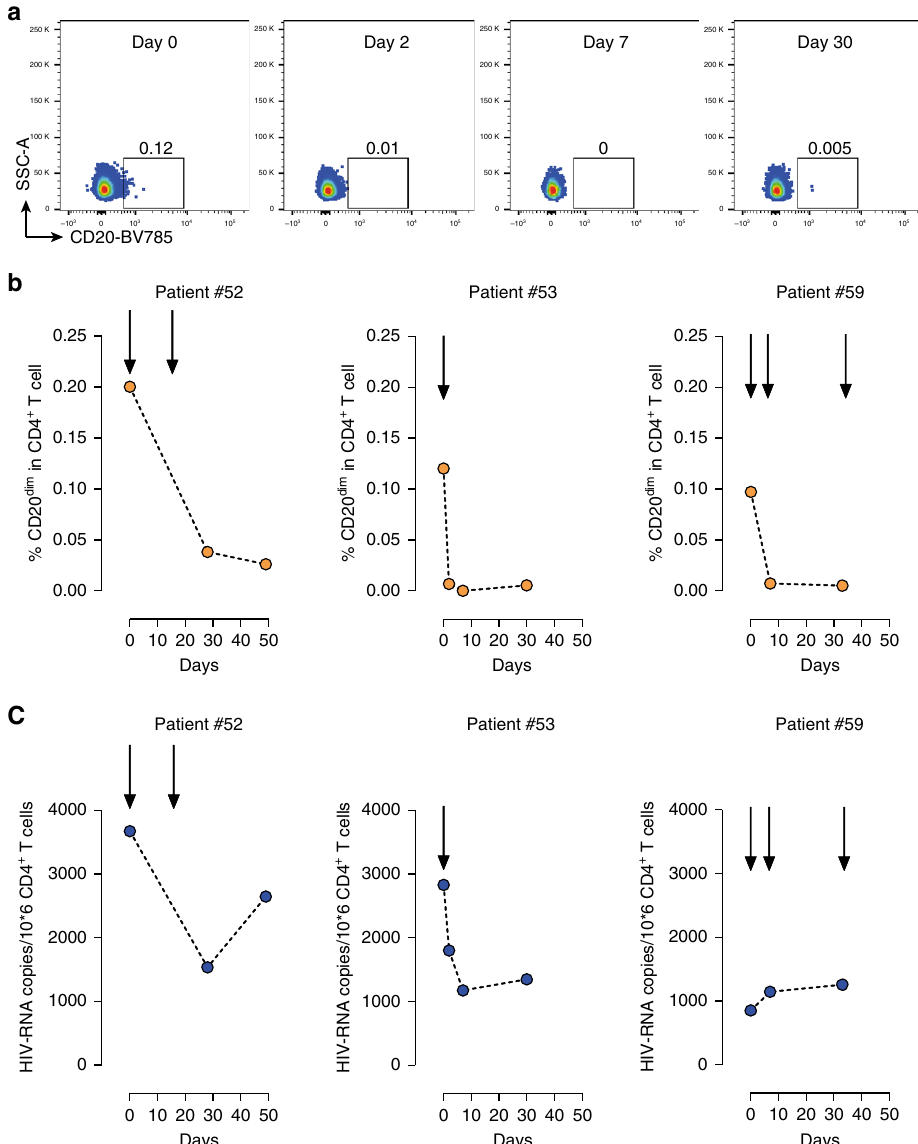
Fig. 7 Effects of Rituximab treatment in CD20 dim CD4 + T cells and intracellular HIV RNA. Three ART-suppressed patients were treated with Rituximab at indicated times (arrows) and blood samples were longitudinally collected. a Flow plots, following the same gating strategy as shown in Fig. 1a, of CD20 expression in CD4 + T cells in patient #53 are shown. b Frequencies of CD20 dim CD4 + T cells in longitudinal samples from three patients are shown. c Copies of HIV RNA per million CD4 + T cells after Rituximab treatment. Individuals #52, #53, #59 are represented. Data underlying this Figure are provided as Source Data fi